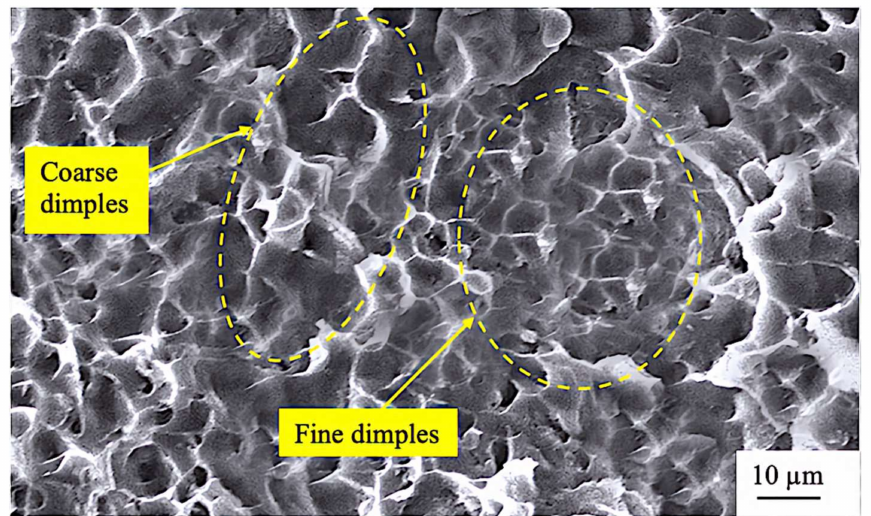
Figure 9. Fracture surface with dimples.